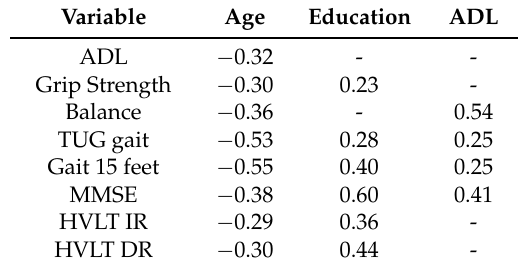
Table 2. Partial correlations of all variables with age (corrected for education), education (corrected for age) and ADL (corrected for age and education). Only Pearson’s r values significant at p < 0.05 with a Bonferroni-Holm correction for all comparisons are shown. Abbreviations: ADL—activities of